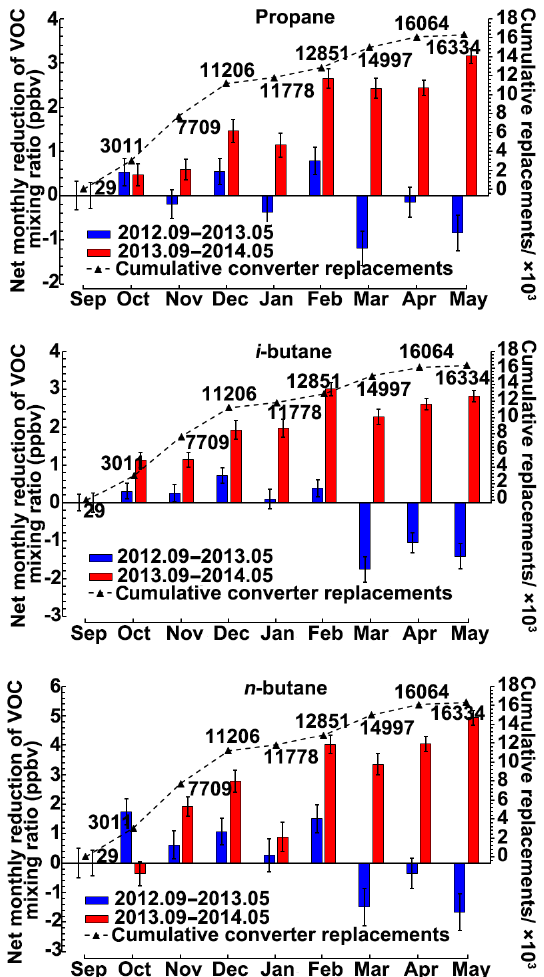
Figure 3. Monthly reductions of LPG-related VOCs at MK before (blue bar) and during (red bar) the program. (The average value of VOC species in September is the baseline. The values along the dot line were the cumulative numbers of converters replaced. The bars above and below the x axis refer to the reduction and increase of VOC mixing ratio, respectively.)